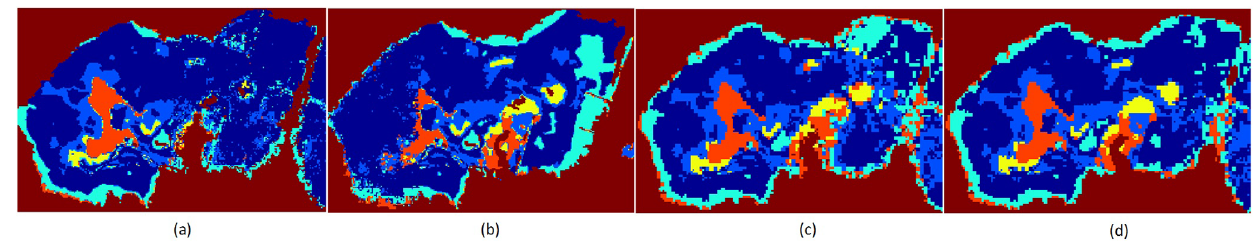
Figure 7. Bagged Tree Classified Image: (a) Sentinel-2 Case 1 (b) Sentinel-2 Case 2 (c) Landsat-8 Case 1 (d) Landsat-8 Case 2.